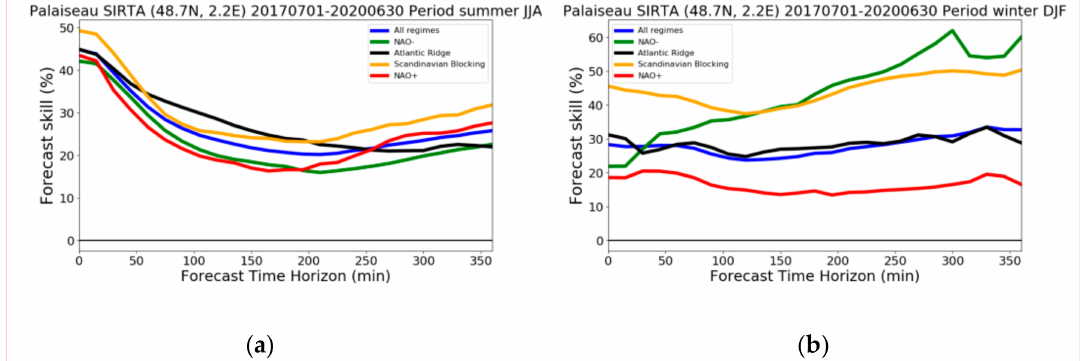
Figure 10. Forecast skills (%) of satellite-based forecast against ARPEGE outputs for the di ff erent weather regimes during ( a ) summer period (JJA) and ( b ) winter period (DJF) from 1 July 2017 to